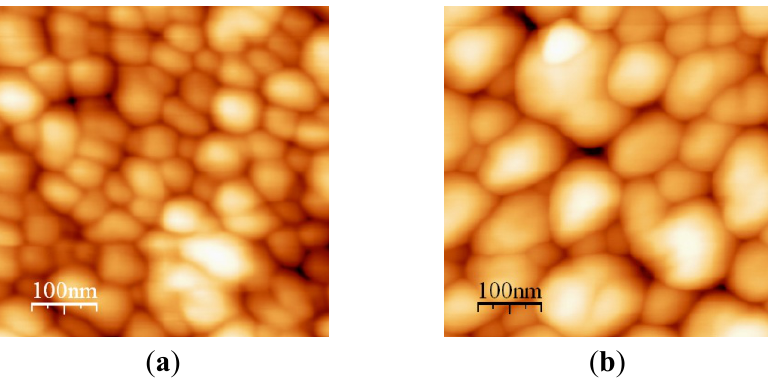
Figure 5. AFM image of Au-PTFE film 2 ( a ) T = 150 °C, size = 40–60 nm; ( b ) T = 220 °C, size = 70–100 nm.